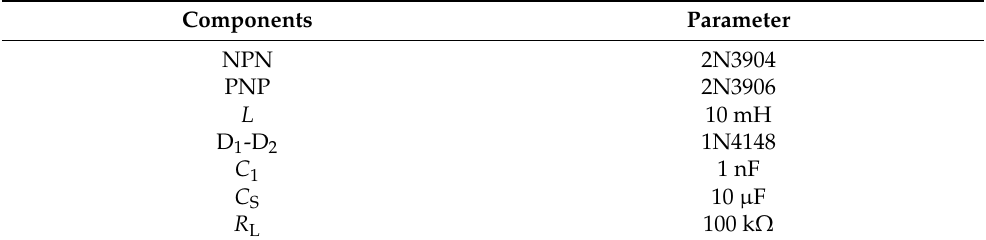
Figure 9. Experimental platform. Table 4. List of components.